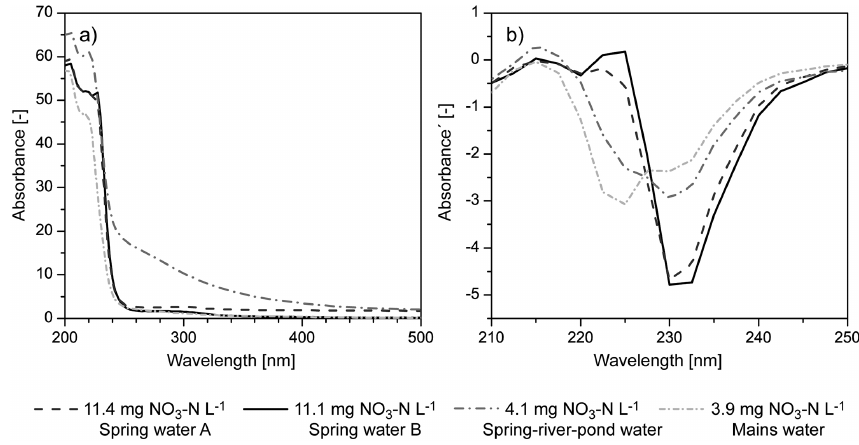
Figure 3. Absorbance vs. wavelength of four different samples measured with the MWS. Spring water A was constantly monitored by the DWS, whereas spring water B was the monitored by MWS. (a) The isosbestic points, which describe the wavelength at which two absorbance spectra are crossing, indicate different matrix compositions of the samples. Nitrate and nitrite are strongly absorbed below 250nm. Other substances such as of COD (chemical oxygen demand), trace organics, humic substances or turbidity in water can increase the absorbance value below 250nm. The maximum influence of those substances can be recognised at higher wavelengths, for example, at the obvious differences of the samples between 250 and 400nm. (b) The first derivative of samples allows a finer interpretation of the nitrate content in the water. The samples with similar nitrate concentration show more similar curve progression than in (a)